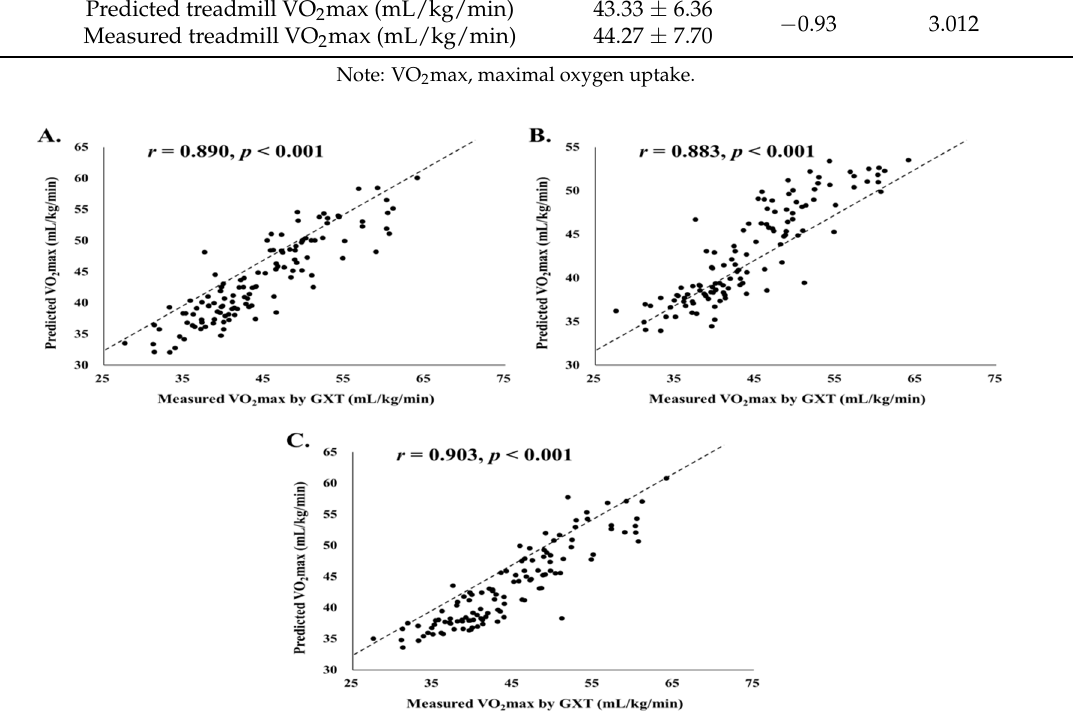
Figure 3. Scatter plot between measured VO 2 max by GXT and the estimated VO 2 max by case 1, case 2, and case 3 of healthy adults. ( A ). Case 1 scatter plot and correlation. ( B ). Case 2 scatter plot and correlation. ( C ). Case 3 scatter plot and correlation. GXT, graded exercise test; VO 2 max, maximal oxygen uptake.